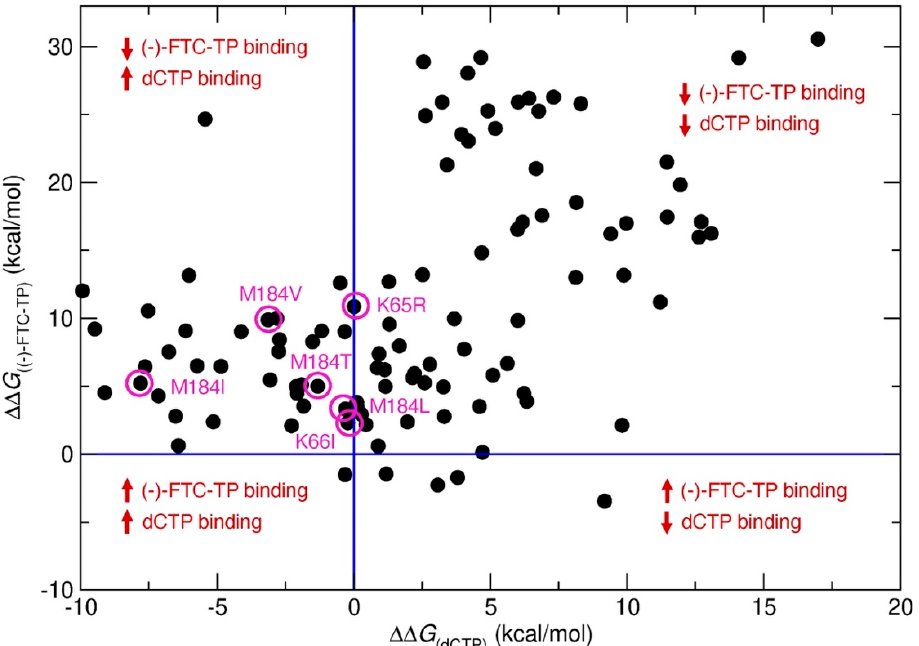
Figure 3. Predicted binding free energy change ( ΔΔ G ) in kcal/mol of native substrate dCTP versus (-)-FTC-TP for single point mutations in HIV-RT. Violet circles represent known clinical (-)-FTC resistance mutations. Table 1. List of predicted resistance mutations in HIV-RT for